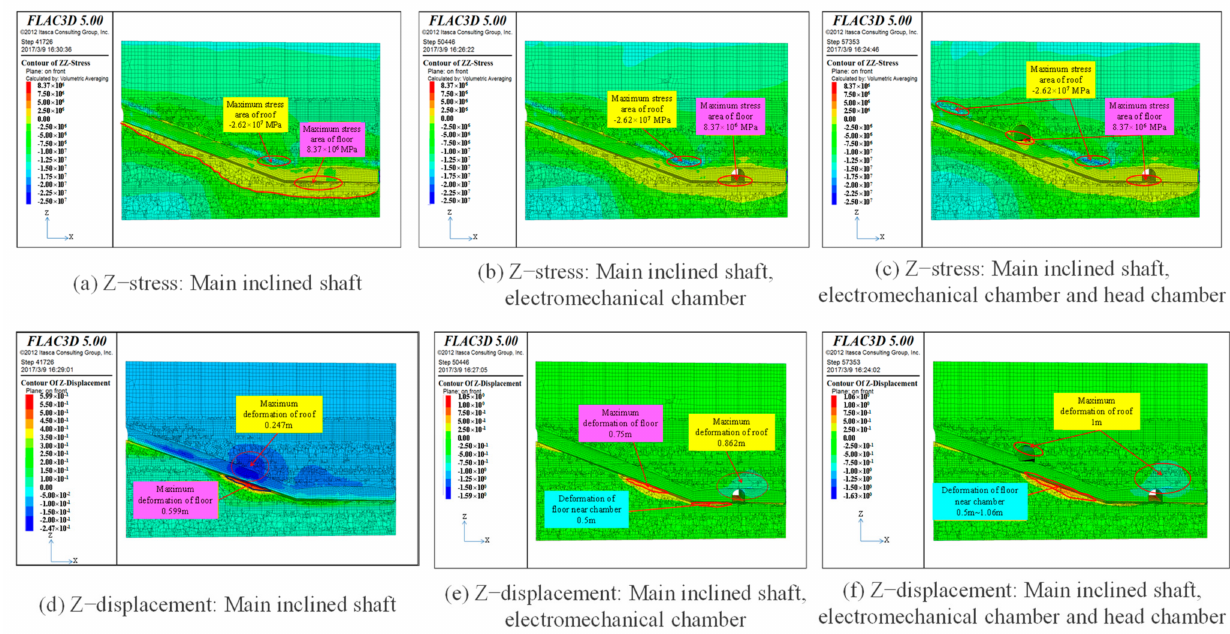
Figure 22. Stress and displacement profile of surrounding rock of main inclined shaft disturbed by